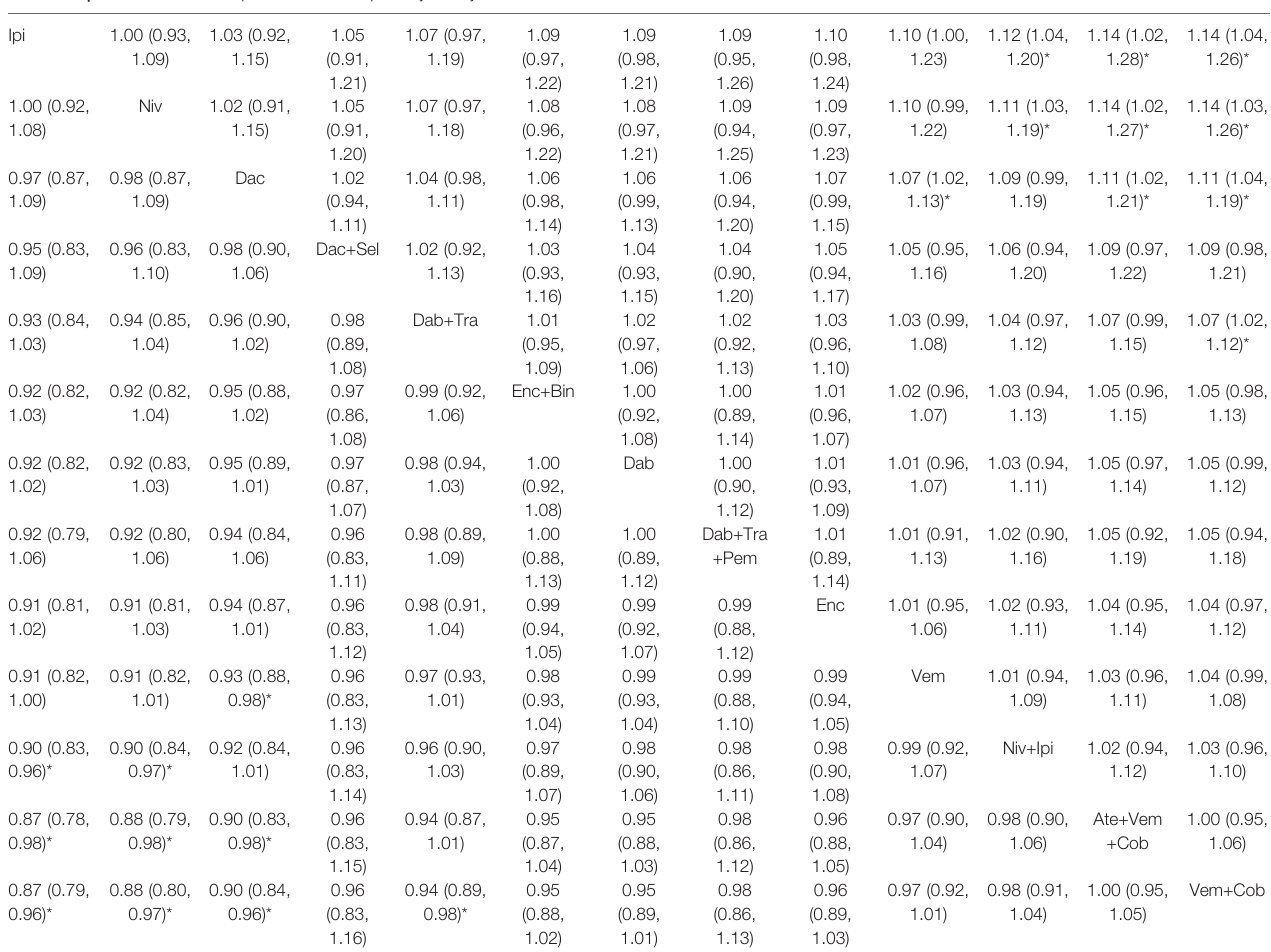
TABLE 2 | Head-to-head comparisons for acceptability of any